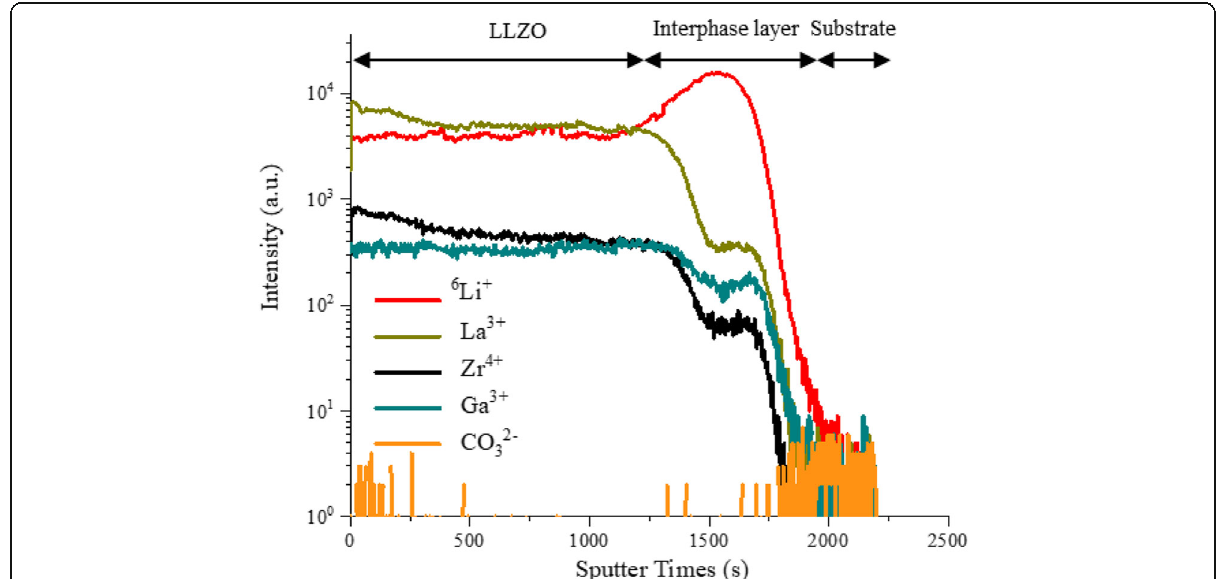
Fig. 4 TOF-SIMS depth profiles of #600-1: 6 Li + (red), La 3+ (green), Zr 4+ (black), Ga 3+ (indigo), CO 32 −